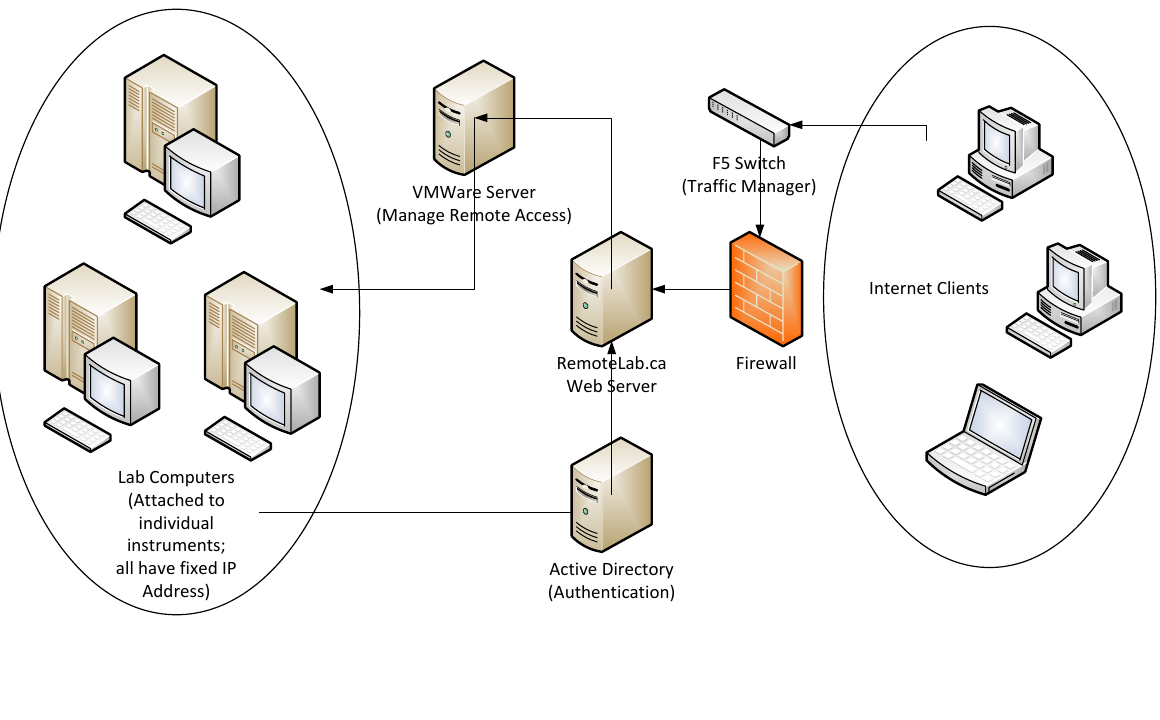
Figure 1. Remote analytical instrument